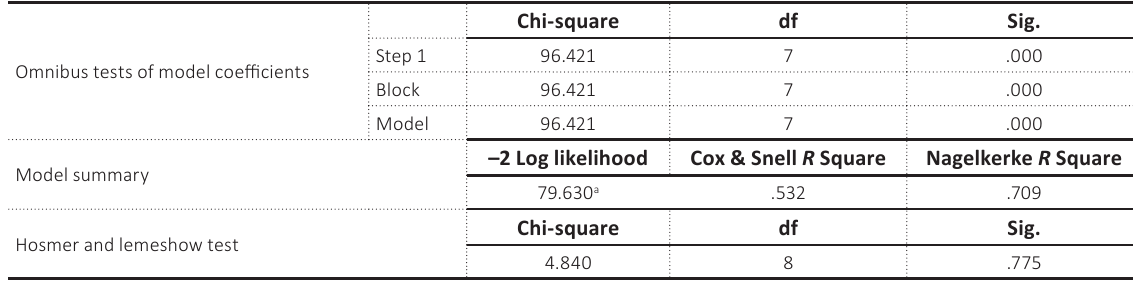
Table 8. Classification table a